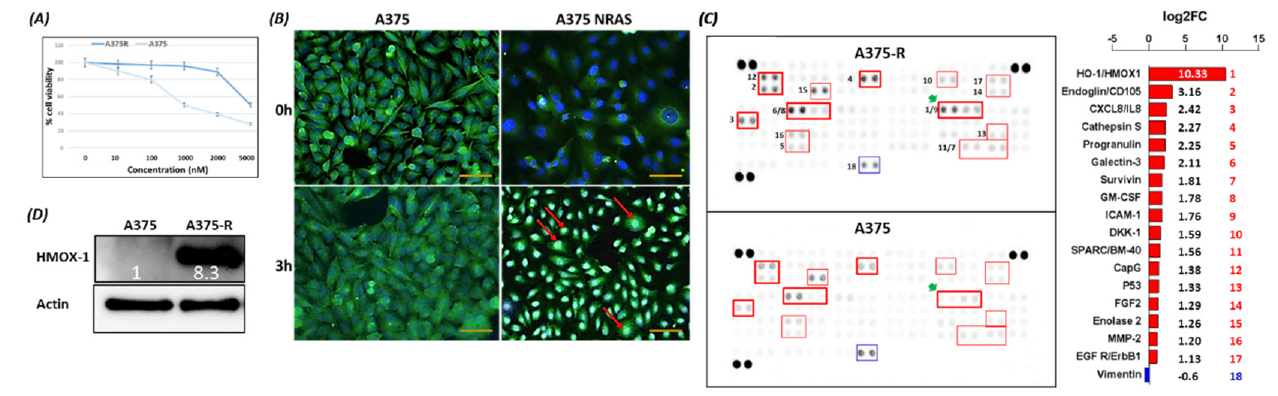
Figure 1. Protein expression of HMOX-1 in parental (P) and resistant A375 (R) cell lines. ( A ) MTT assay was assessed on parental and resistant A375 cell lines after treatment with different concentrations of vemurafenib for 3 days. This experiment was performed in triplicate and independently repeated three times. ( B ) IF with BRAF V600E antibody. Cells were synchronized and then stimulated with FBS for 3 h. Scale bar = 20 μ m ( C ) Human XL oncology array (relative levels of 84 human cancer-related proteins) incubated with total protein extractions collected from parental and resistant A375 cell lines. ( D ) HMOX-1 protein levels in parental A375 cells and resistant A375 cells.